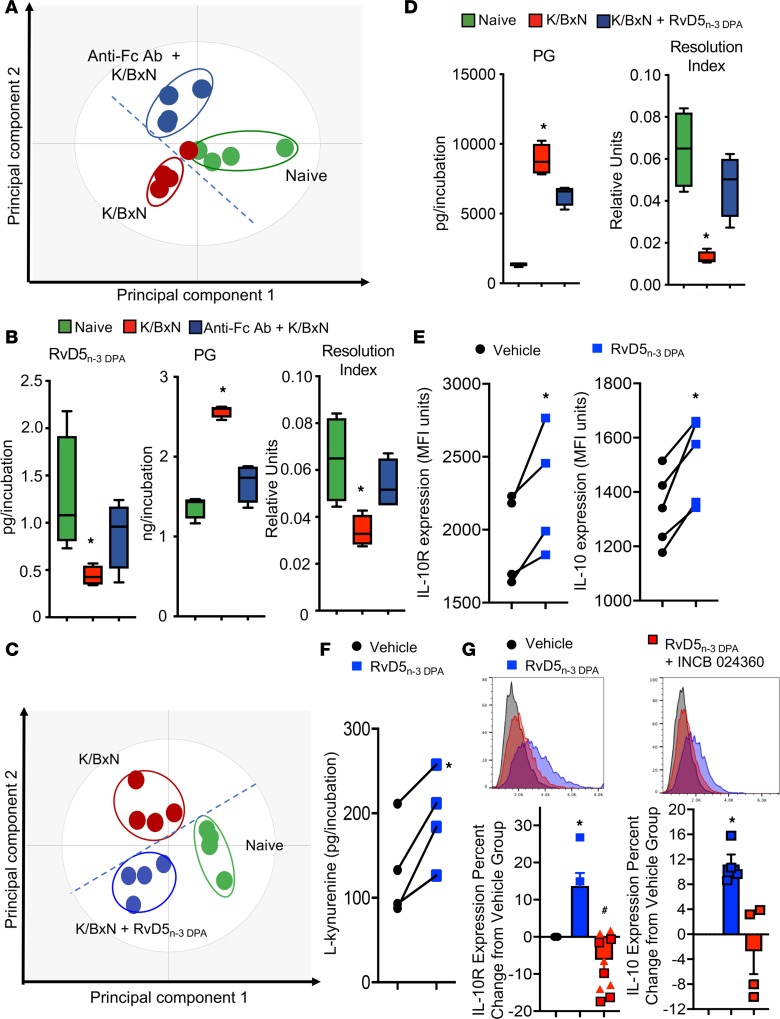
RvD5n-3 DPA rectifies intestinal macrophage lipid mediator profiles and upregulates macrophage IL-10 and IL-10R expression via the activation of IDO and AHR.(A and B) Lamina propria macrophages were isolated from naive mice and incubated with vehicle (Naive), isotype control antibodies (K/BxN), or anti-CD16 and anti-CD32 antibodies (anti-Fc Ab + K/BxN) for 20 minutes (37°C). Cells were then incubated with vehicle or K/BxN serum (1:1000 dilution; 16 hours at 37°C). Incubations were quenched with ice-cold methanol and lipid mediators identified and quantified using lipid mediator profiling. (A) oPLS-DA of lipid mediator profiles. (B) Concentrations of RvD5n-3 DPA (left panel), prostaglandins (PG; center), and ratio of proresolving mediators to proinflammatory eicosanoids (Resolution Index; right). Results are mean ± SEM, with horizontal bars depicting mean values. n = 4 mice per group. *P < 0.05 versus naive using Kruskall-Wallis test followed by Dunn’s post hoc test. (C and D) Lamina propria macrophages were isolated from naive mice and arthritic mice and then incubated with either vehicle (K/BxN) or RvD5n-3 DPA (10 nM; K/BxN + RvD5n-3 DPA) for 20 minutes (37°C; 16 hours). Incubations were quenched with ice-cold methanol, and lipid mediators were identified and quantified using lipid mediator profiling. (C) oPLS-DA of lipid mediator profiles. (D) Concentrations of prostaglandins (left panel) and resolution index (right). Results are mean ± SEM. n = 4 mice per group. *P < 0.05 versus naive using Kruskall-Wallis test followed by Dunn’s post hoc test. (E) Bone marrow–derived macrophages were incubated with 10 nM RvD5n-3 DPA or vehicle (16 hours, 37°C), and IL-10R and IL-10 expression was determined using flow cytometry. (F) Bone marrow–derived macrophages were incubated with 10 nM RvD5n-3 DPA or vehicle (2 hours, 37°C) and concentrations of l-kynurenine measured by LC-MS/MS. (G) Bone marrow–derived macrophages were incubated with 20 μM INCB 024360 or vehicle (30 minutes, 37°C), then with 10 nM RvD5n-3 DPA or vehicle (16 hours, 37°C) and IL-10R and IL-10 expression determined using flow cytometry (lower panels). Representative histograms are shown (upper panels). Results for E–G are mean ± SEM. n = 4–5 mice per group from 2 independent experiments. *P < 0.05 versus vehicle group using Mann-Whitney U test for E and F, and Kruskall-Wallis test followed by Dunn’s post hoc test for G.